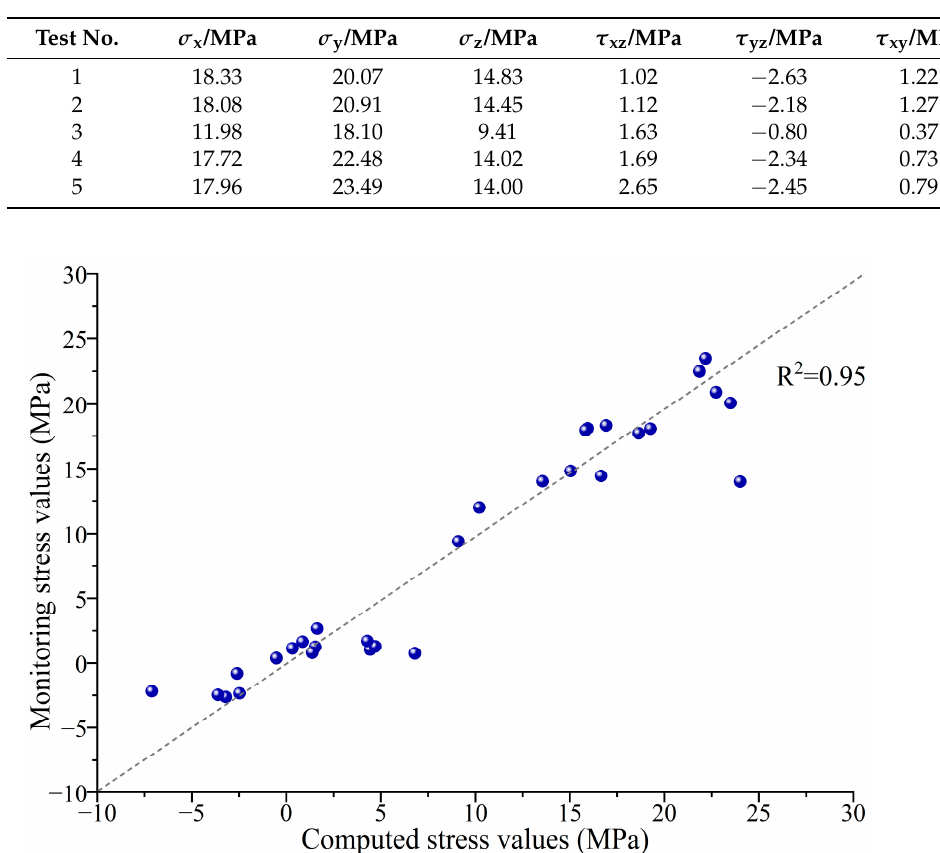
Figure 6. Comparison of inverted results with measured results.